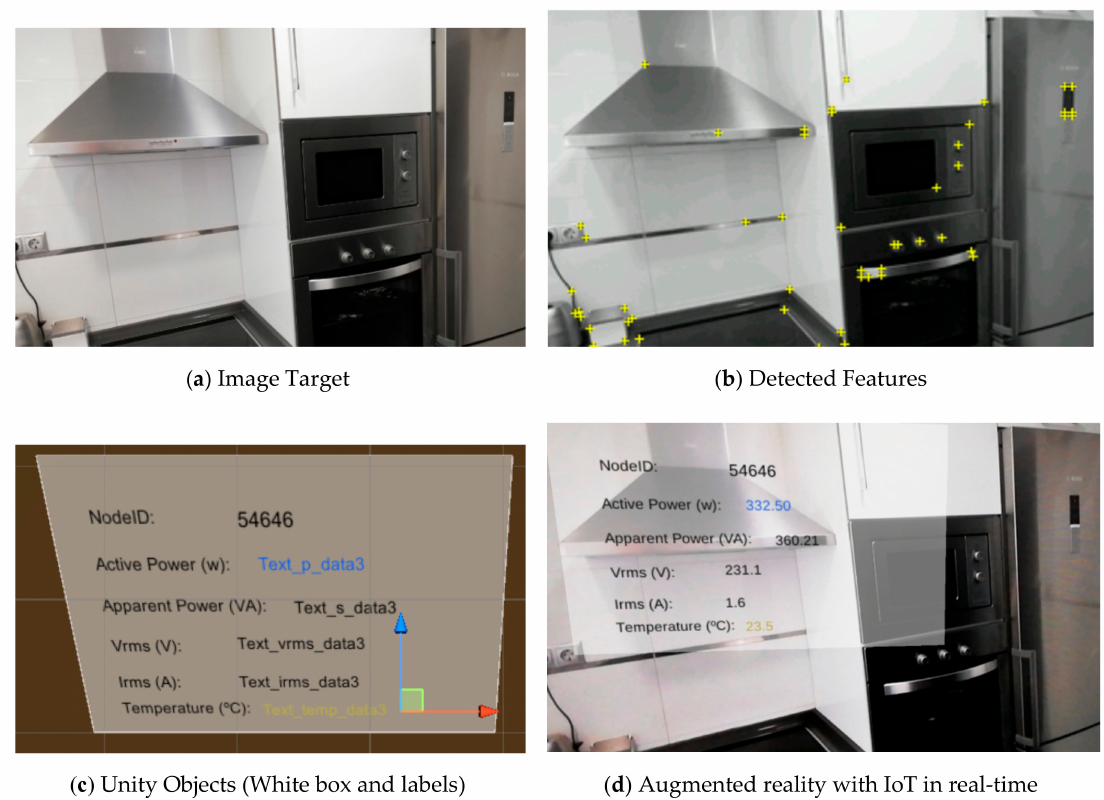
Figure 3. Vuforia and Unity